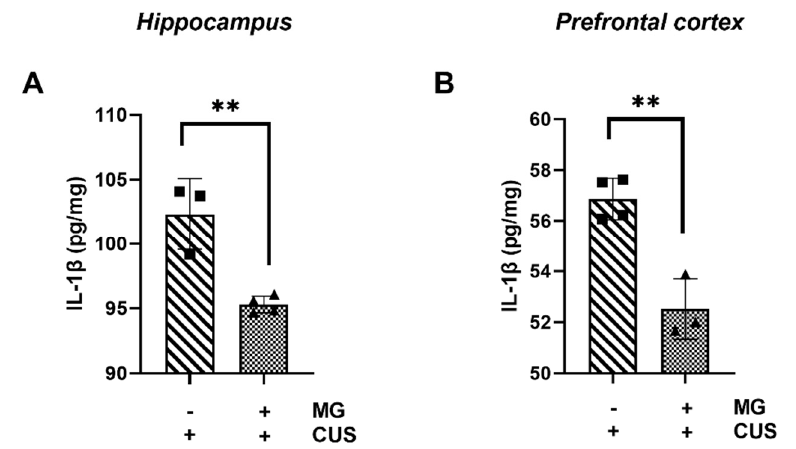
Figure 7. ELISA analysis for IL-1 β protein levels in the hippocampus ( A ) and in the prefrontal cortex ( B ). All graphs represent mean ± s.e.m. Significance levels, as calculated by unpaired t test, are indicated as: ( A ) (cid:4) vs. (cid:78) ** p = 0.0038; ( B ) (cid:4) vs. (cid:78) ** p = 0.0022.